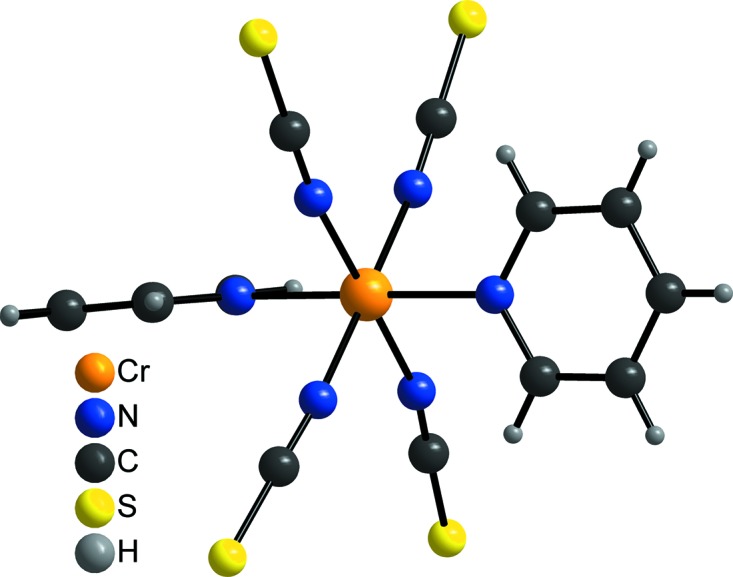
View of the coordination sphere of the CrIII ion.